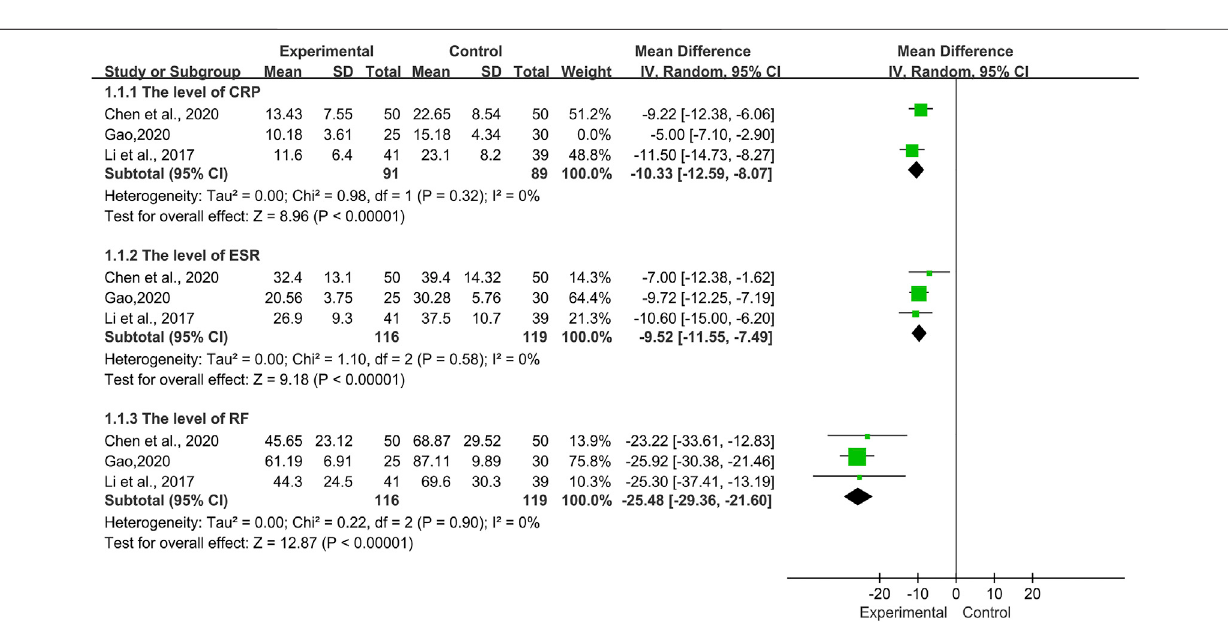
Frontiers in Pharmacology |